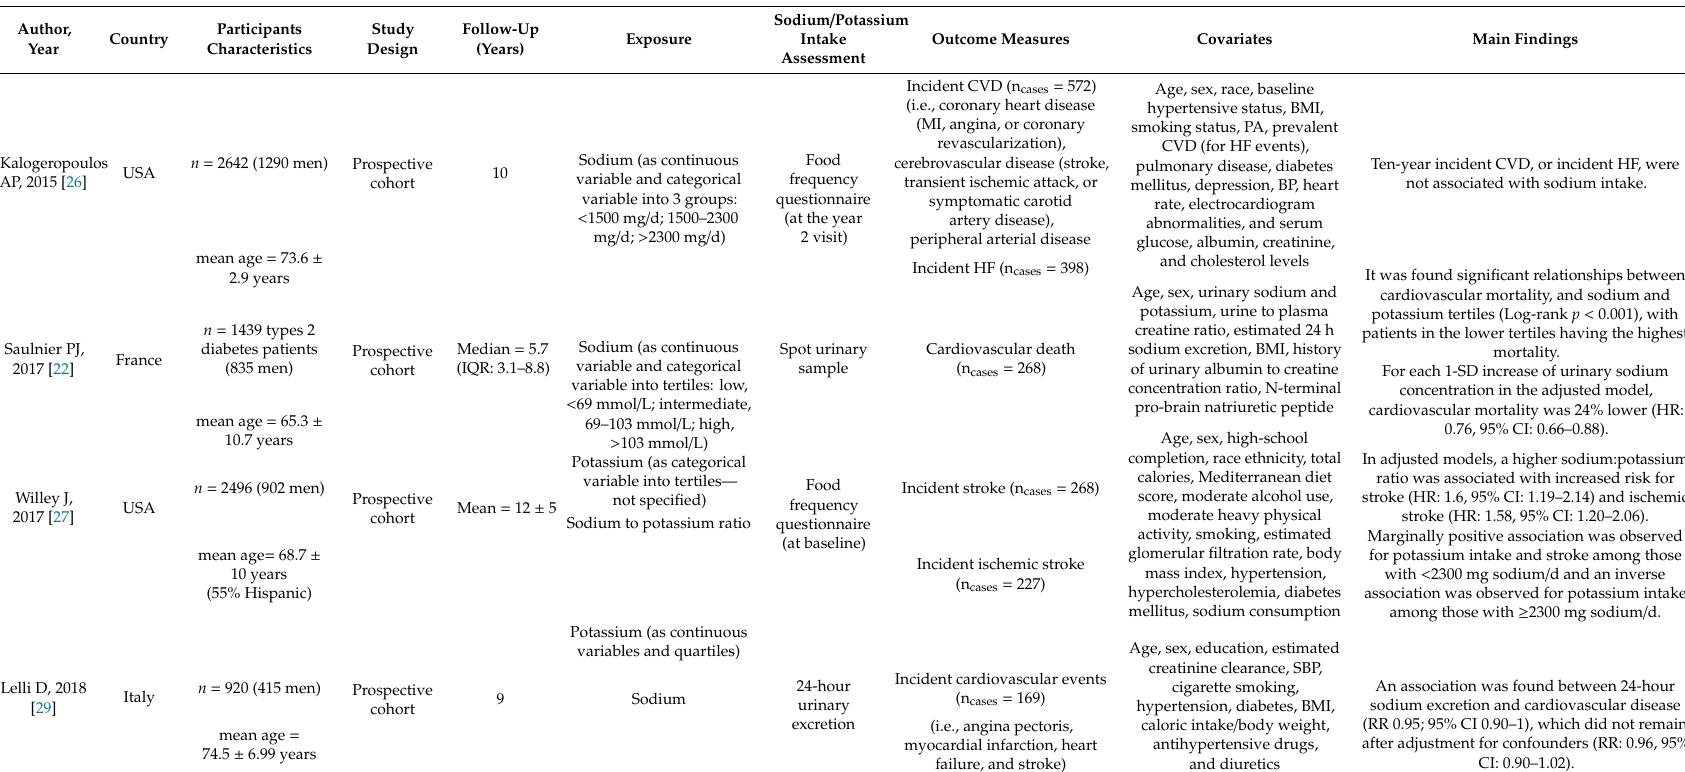
Table 2. Characteristics of included longitudinal studies in systematic review of dietary sodium, potassium, sodium-to-potassium ratio, and cardiovascular